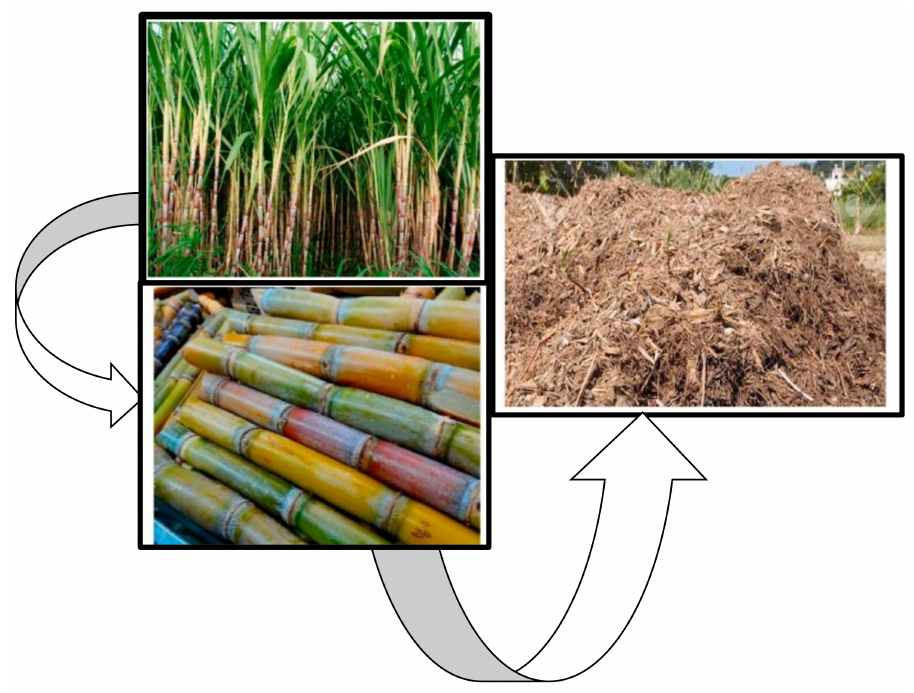
Figure 2. Images of a typical sugarcane plantation, stalks, and bagasse from the South African sugar industry